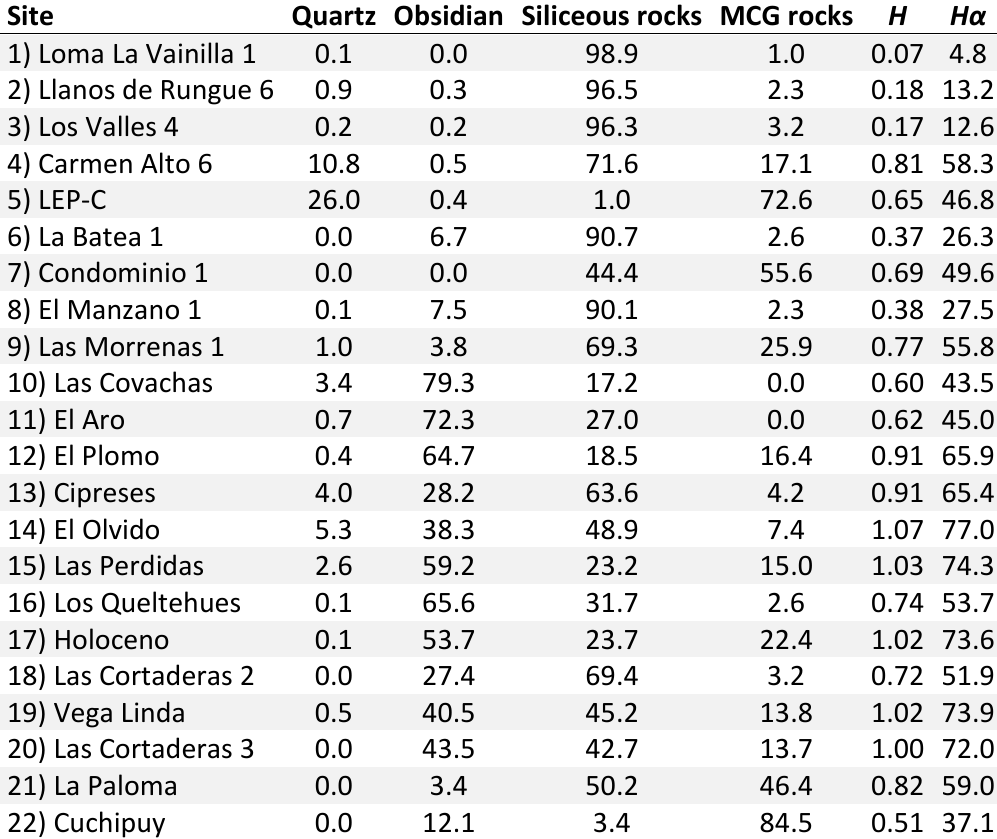
Table 1. Types, proportions, and diversity measures for raw materials found at the sites studied